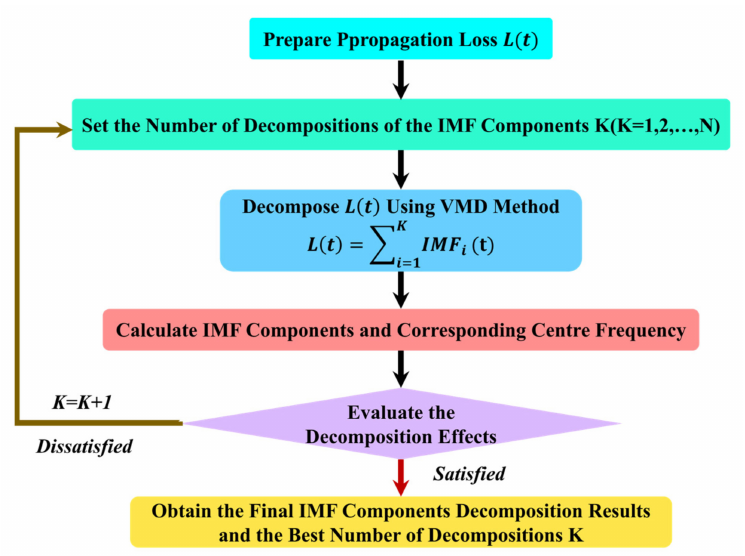
Figure 7. Process for calculating the central frequency of different decomposition numbers.